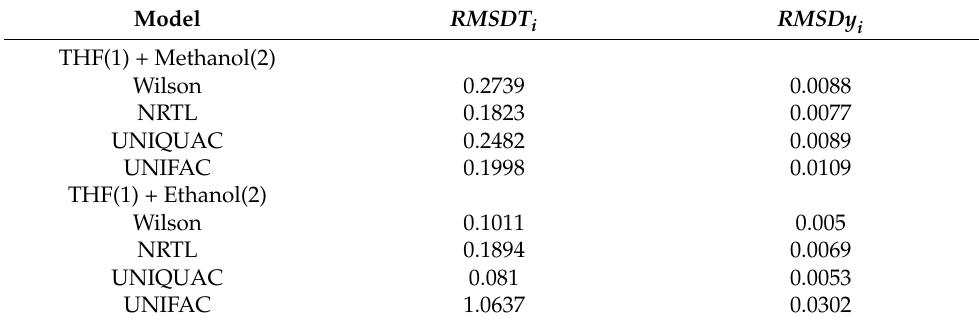
From Table 7, the UNIQUAC model for isothermal systems THF(1) + Benzene(2) and Table 8, the NRTL model for the isobaric system THF(1) + Methanol(2) and UNIQUAC model THF(1) + Ethanol(2) fitted the experimental data better than the